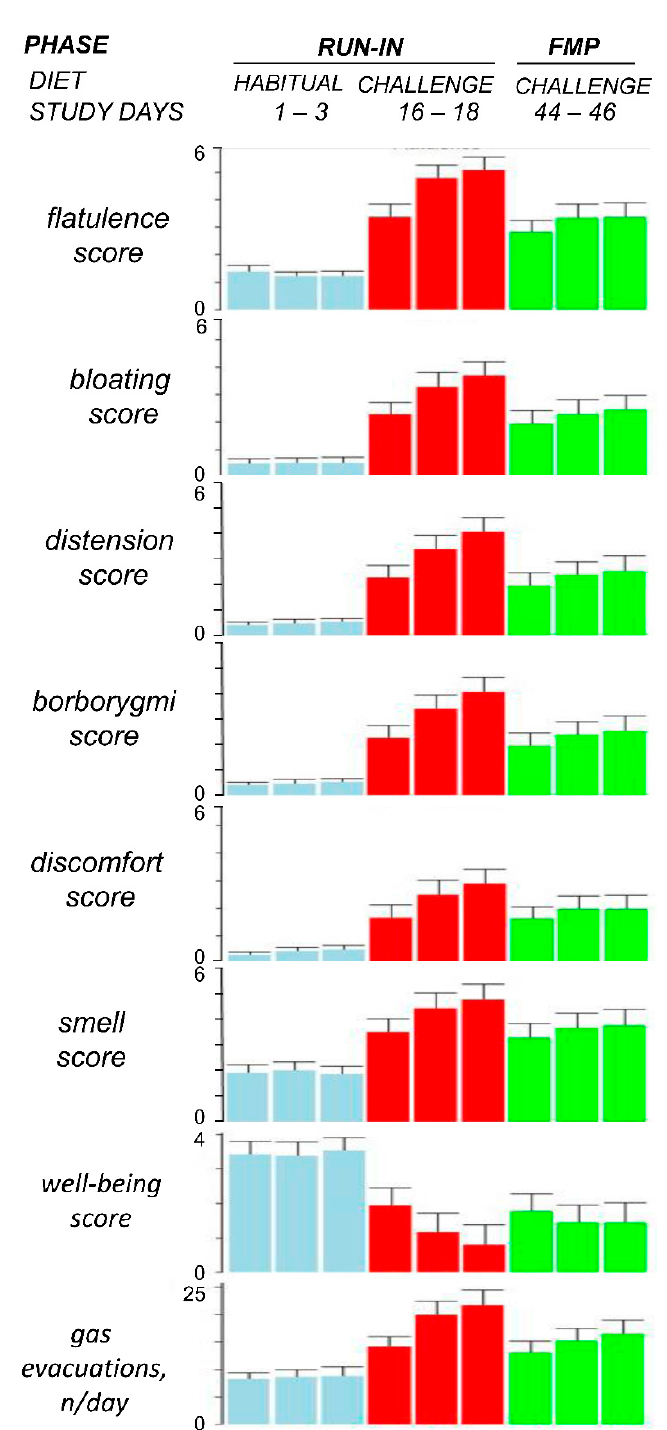
Figure 3. Tolerance of the flatulogenic diet. FMP: fermented milk product administration phase. To show daily variability, data of the 3 days of each evaluation period are represented; note similar values on days 2 and 3 within each period. Statistical comparisons were performed by Wilcoxon signed rank test using the average of days 2 and 3 of each period: p < 0.0001 for all parameters habitual diet vs. challenge diet during run-in phase ( n = 74); p < 0.0001 for all parameters challenge diet during run-in phase vs. challenge diet during FMP administration phase ( n = 66) except for abdominal discomfort/pain and digestive well-being ( p < 0.05).